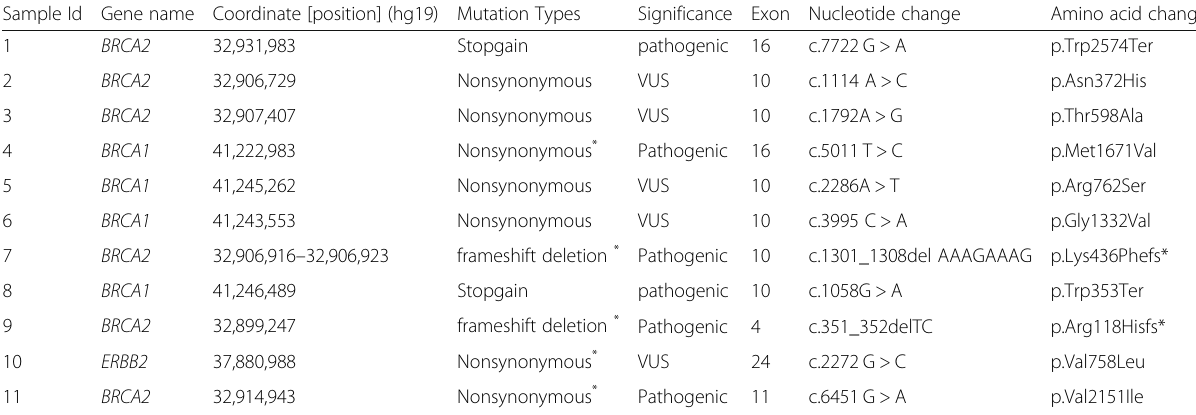
Table 2 List of clinically relevant variants detected within the BRCA1, BRCA2 and ERBB2 genes applying targeted sequencing from blood derived DNA samples in our breast cancer cohort recruited from Bangladesh Sample Id Gene name Coordinate [position] (hg19) Mutation